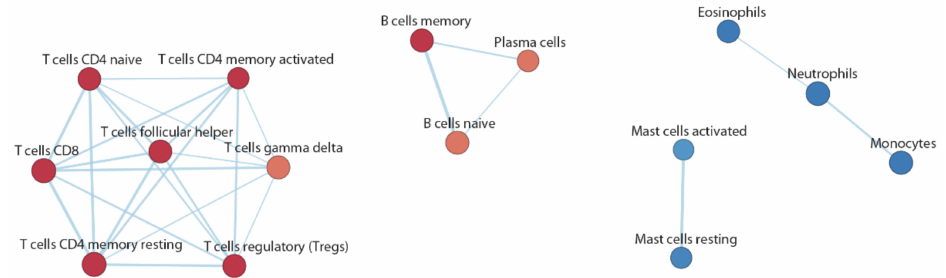
Figure 4. Cell enrichment map. The red nodes represent the enriched cells in the CAD phenotype, while the blue nodes were enriched in the noCAD phenotype and negatively associated with